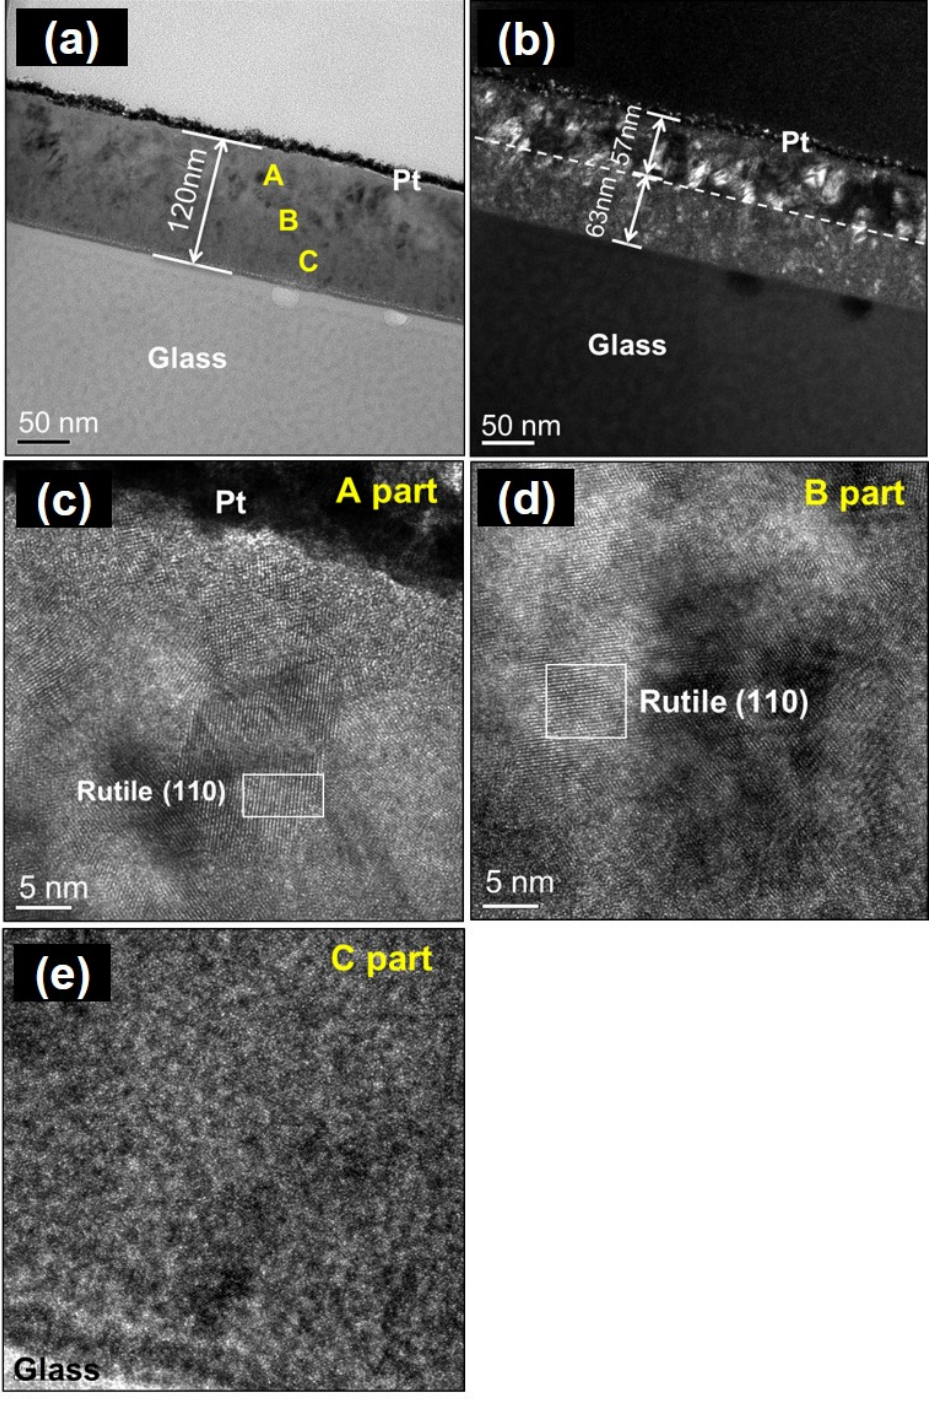
Figure 4. TEM micrographs of a sample 1 thin film thermally oxidized at 450 ◦ C: ( a ) bright field, ( b ) dark field, ( c ) HR-TEM image showing point A, ( d ) HR-TEM image showing point B, and ( e ) HR-TEM image showing point C.